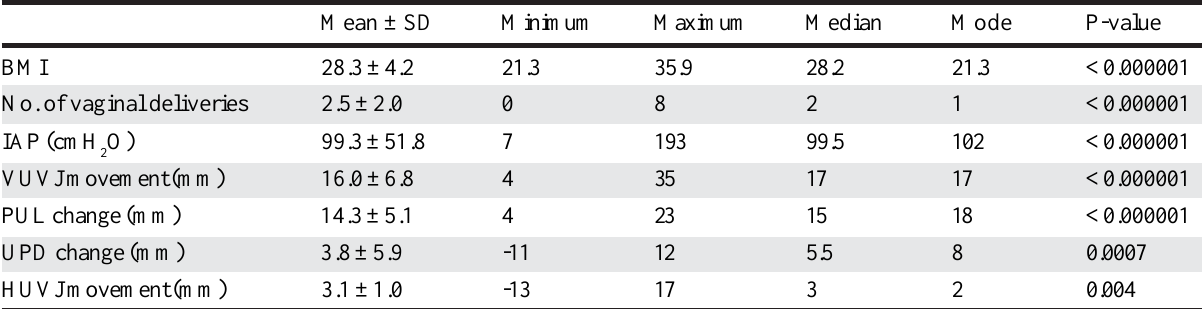
TABLE 1 - Measurements of variables of interest from the study population.